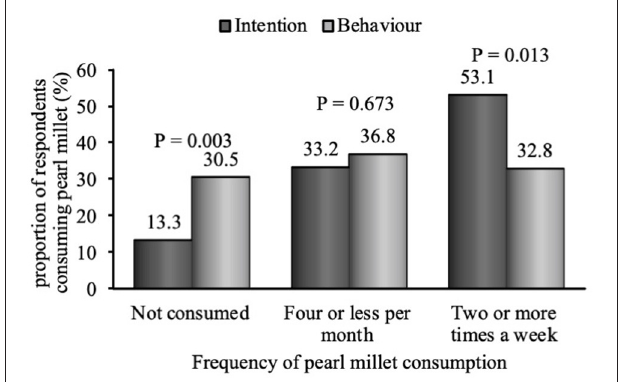
FIGURE 1 | Comparison of pearl millet consumption between behavioral intention and behavior ( n = 128). P -value obtained using chi-square test comparisons of per cent of intention and behavior. Significant difference between intention and behavior P ≤ 0.10.